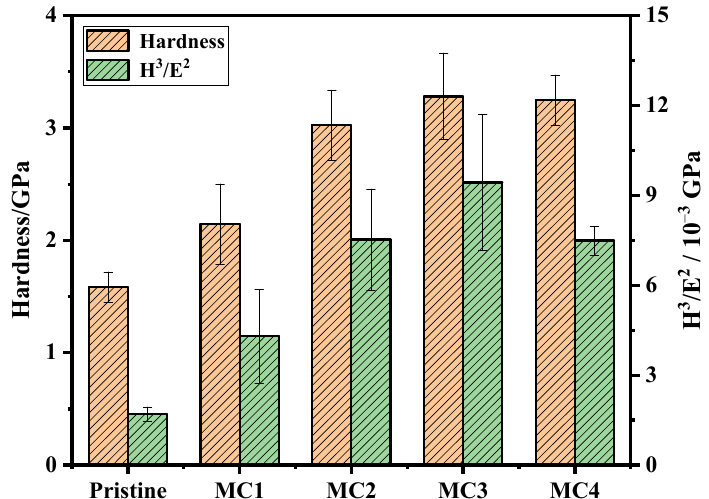
Figure 6. Hardness and H 3 /E 2 of the MOST/C nano-multilayer before and after irradiation.